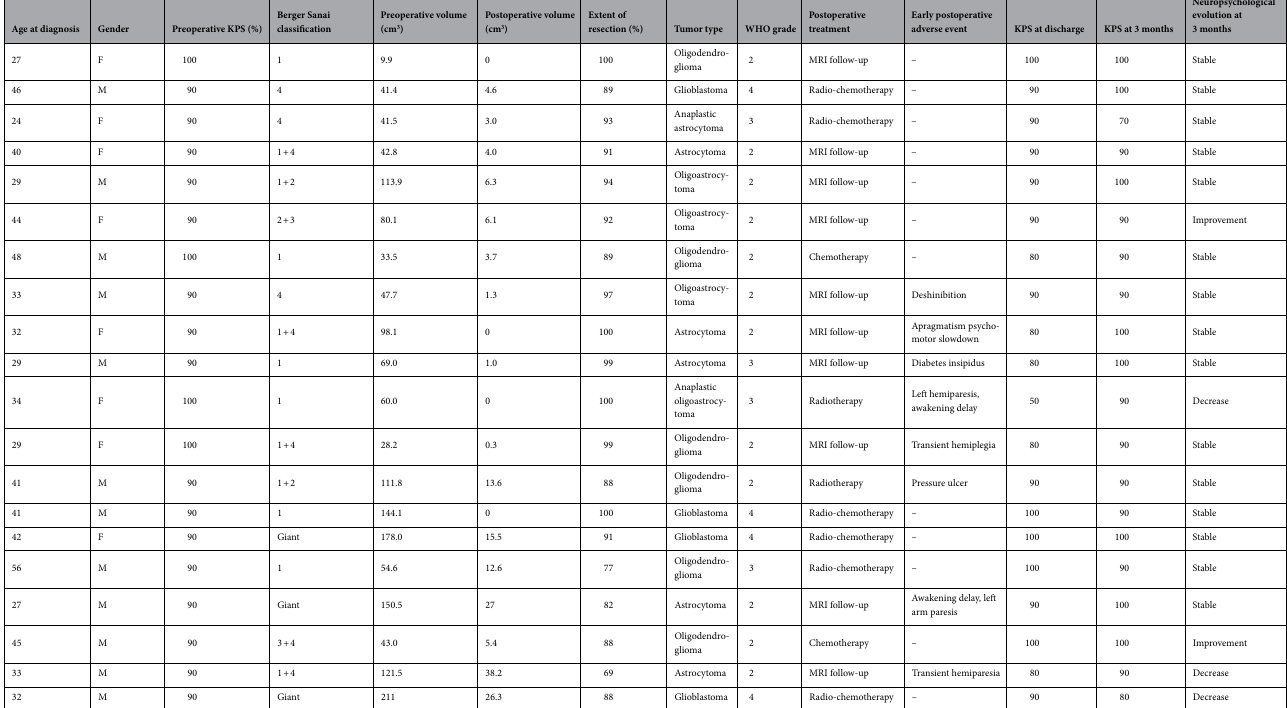
Table 1. Descriptive data of the 20 operated